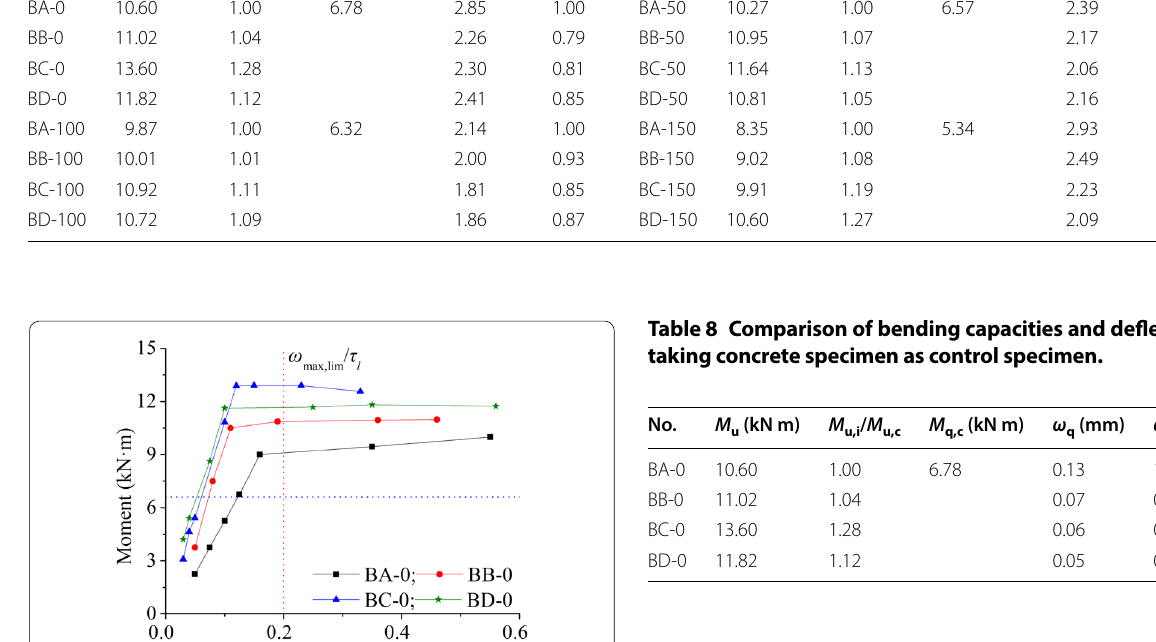
Table 7 Comparison of bending capacity and deflection - taking concrete specimen as control specimen. No.